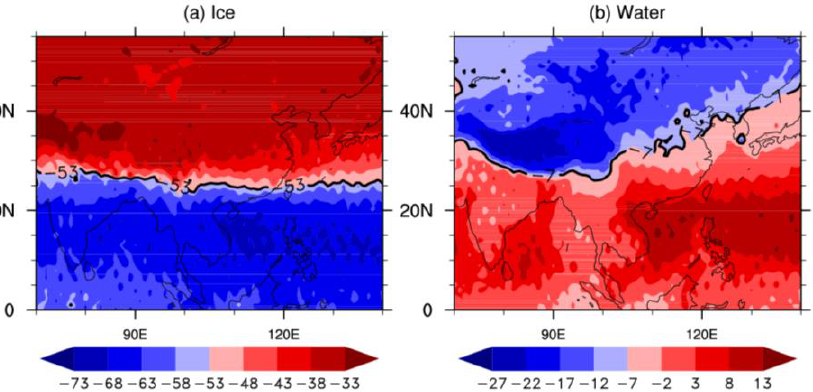
Figure 14. Spatial distribution of temperature in the cloud: ( a ) ice clouds and ( b ) water clouds. The black thick solid line is the valley temperature, the blue shading is below the valley temperature and the red shading is above the valley temperature. Unit: ◦